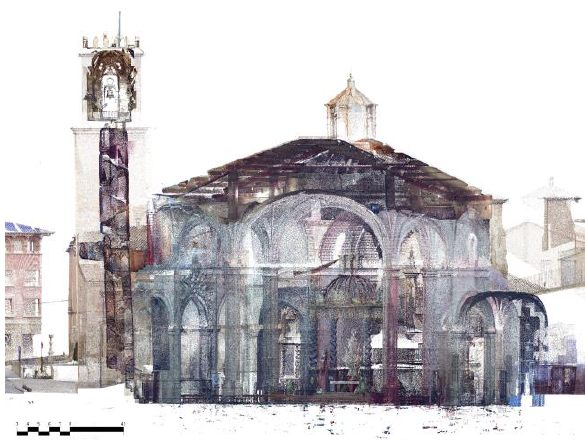
Figure 6. Cross-sectional scale orthophoto of the tower. All these views in orthogonal projection (floors, vertical sections and elevations) can be converted into JPG format images by performing scaled orthophotos (Figure 6).